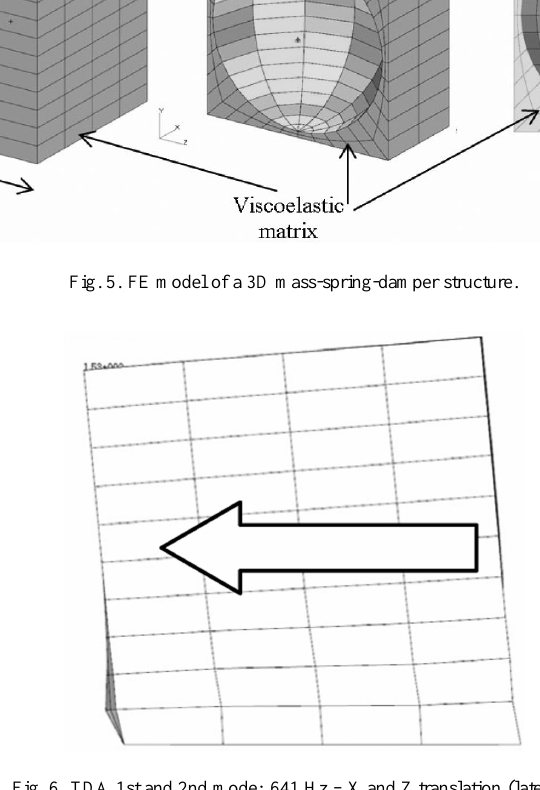
Fig. 6. TDA 1st and 2nd mode: 641 Hz – X and Z translation